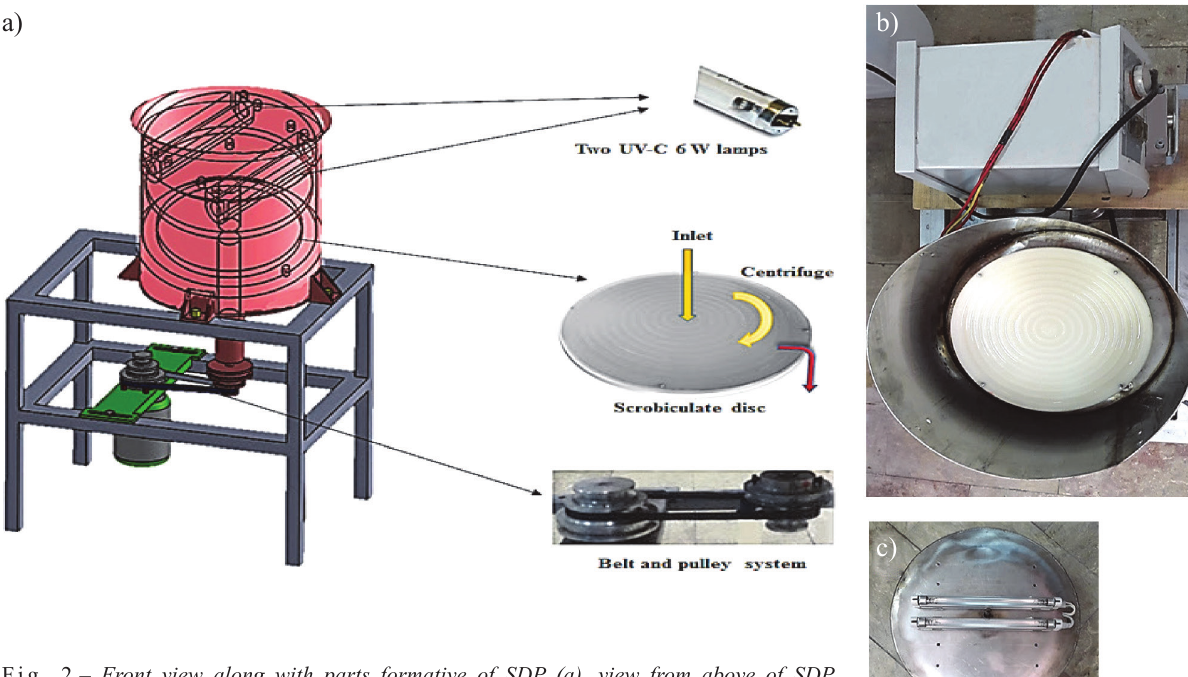
Fig. 2 – Front view along with parts formative of SDP (a), view from above of SDP (b) and image of the lamps embedded in SDP (c)